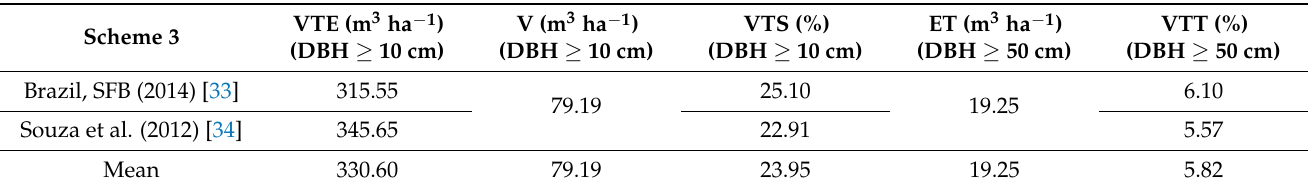
Table 5. Volume stock of all species for the study area extrapolated from the literature, commercial species as a percentage of the volume of all species and volume of the commercial boles (harvested trunks) as a percentage of the volume of all species. Scheme 3